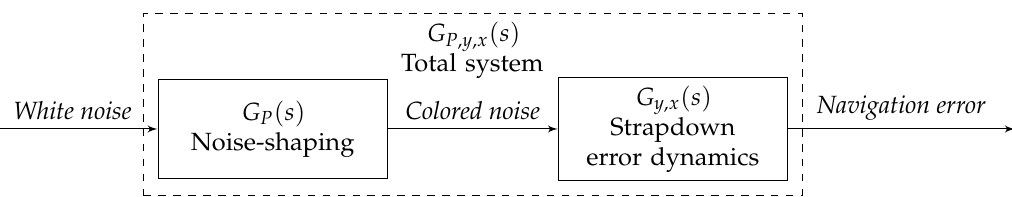
Figure 3. Determination of the strapdown inertial navigation system’s error response to colored noise by including a noise-shaping filter into the system’s transfer